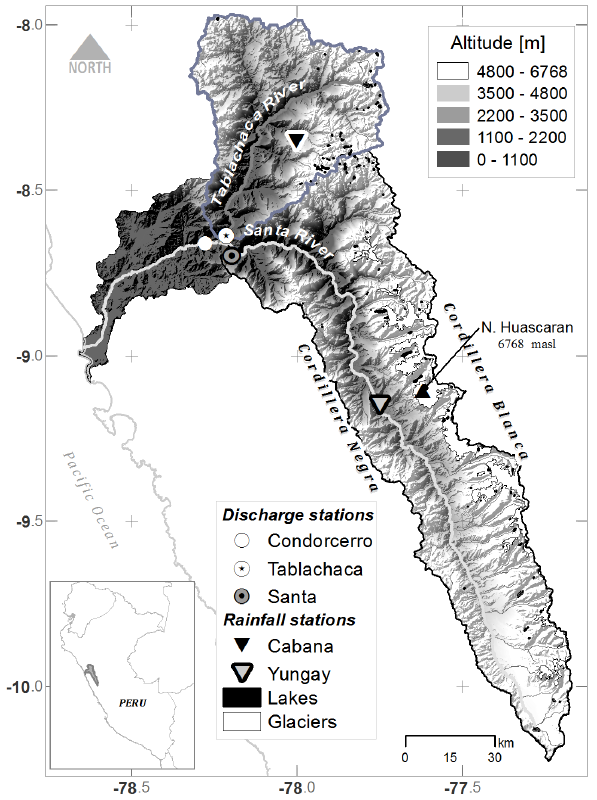
Fig. 1. Shaded-relief and elevation map of the Santa and Tablachaca study catchments in the west-central Andes (SRTM, 2002). Circles indicate locations of the monitoring stations.